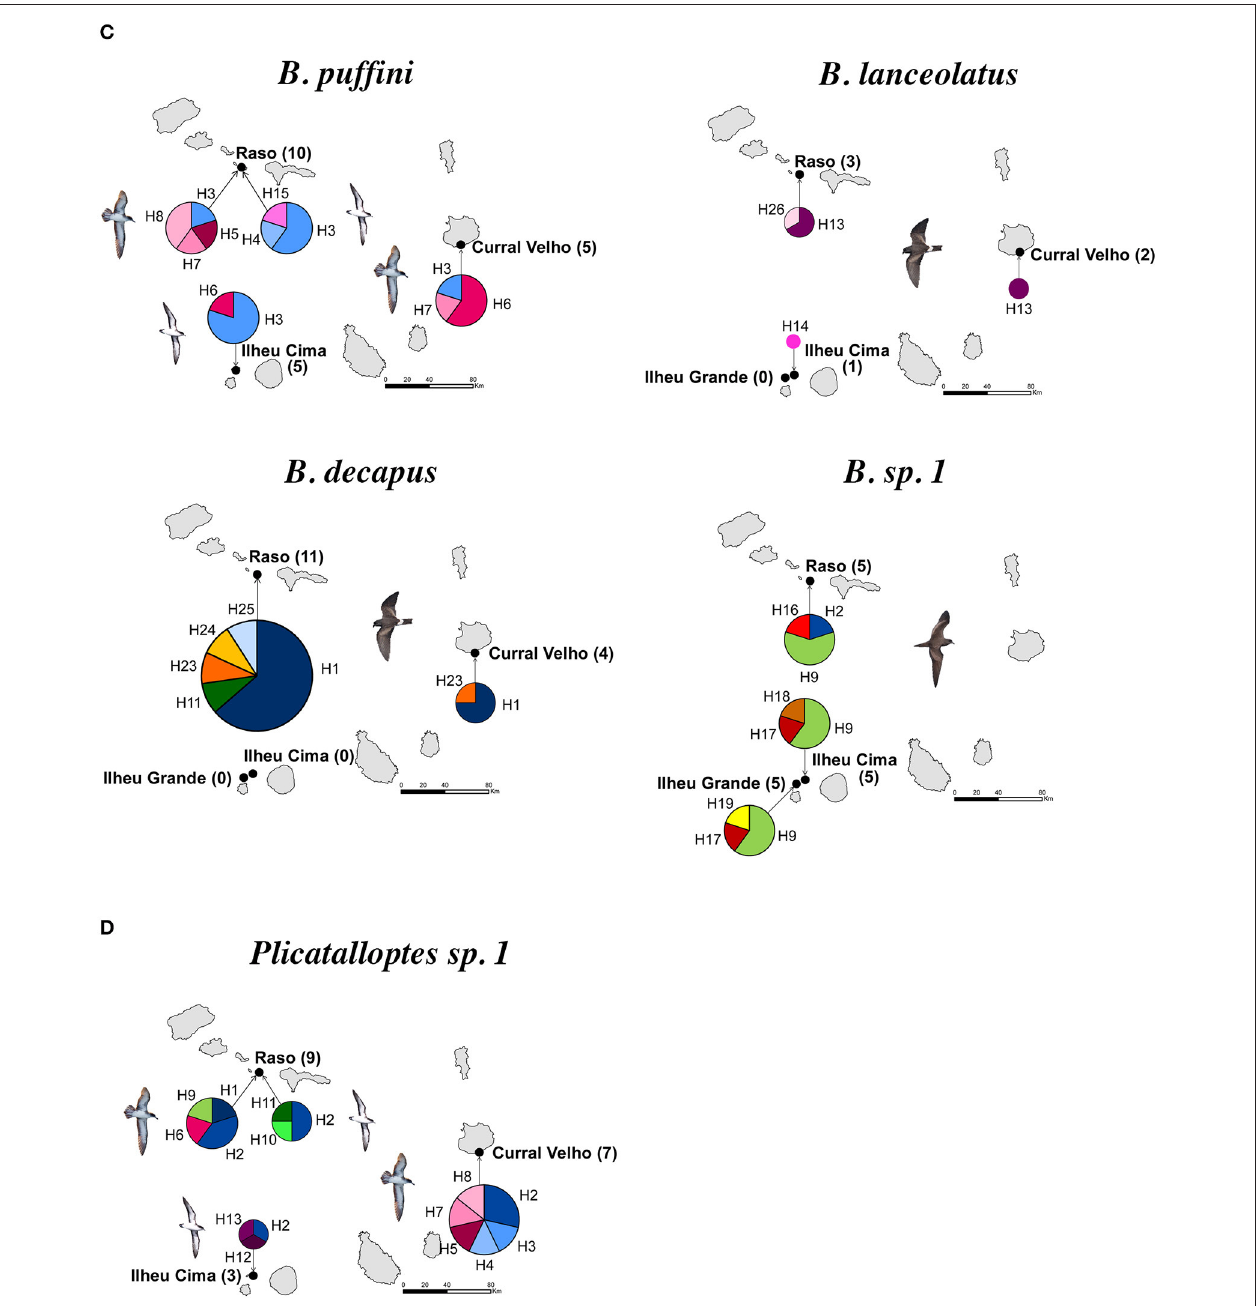
FIGURE 3 | Geographic distribution of haplotypes for seabird feather mites Zachvatkinia (A) , Microspalax (B) , Brephosceles (C) , and Plicatalloptes (D) from the Cape Verde Islands based on the concatenation of two mitochondrial genes (12S and 16S). Each color represents a different haplotype and the size of each haplotype is proportional to the number of individuals having that haplotype. The number of mite individuals analyzed in each locality is shown in